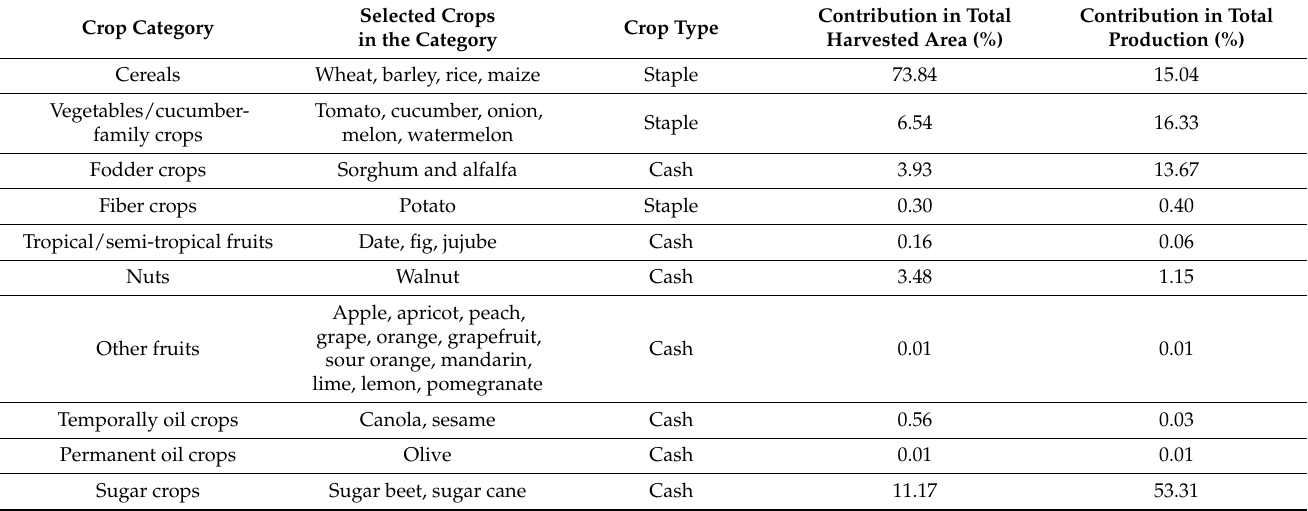
Figure 2. Temporal growth of ( a ) harvested area and ( b ) total production of different crop categories in the Khuzestan province over the period 1986–2016. Table 1. Selected crops under each crop category, and their overall contributions in total harvested area and production in the Khuzestan province over the period